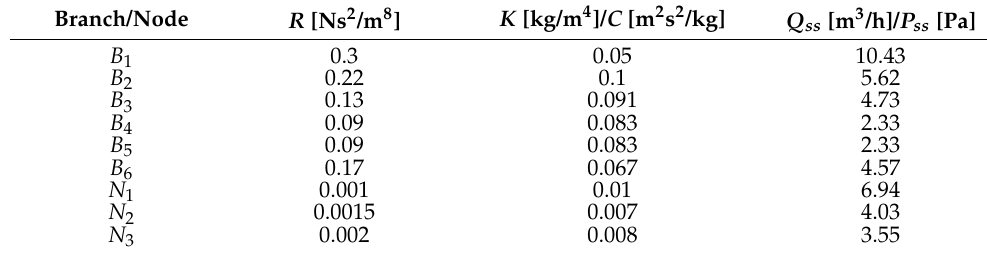
Figure 5. Scheme of a mine with six branches and three nodes. Table 2. Parameters of the ventilation network in example